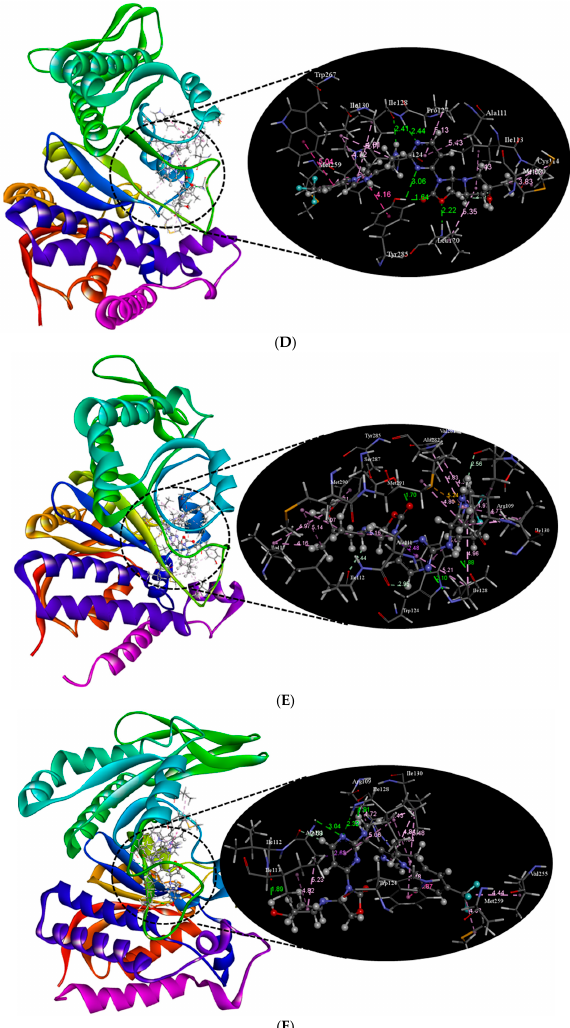
Figure 8. The receptor–ligand 3D interaction of reference compound ( A ) (RC-01), ( B ) (RC-02), and the designed compounds ( C ) (DC-01), ( D ) (DC-02), ( E ) (DC-03) and ( F ) (DC-04) after the simulation at the final frame (50 ns). Green—Classical and non-classical hydrogen bond interactions, Cyan—halogen induced hydrogen bond interactions, Lavender—alkyl-alkyl and pi-alkyl interactions, Magenta—pi- pi